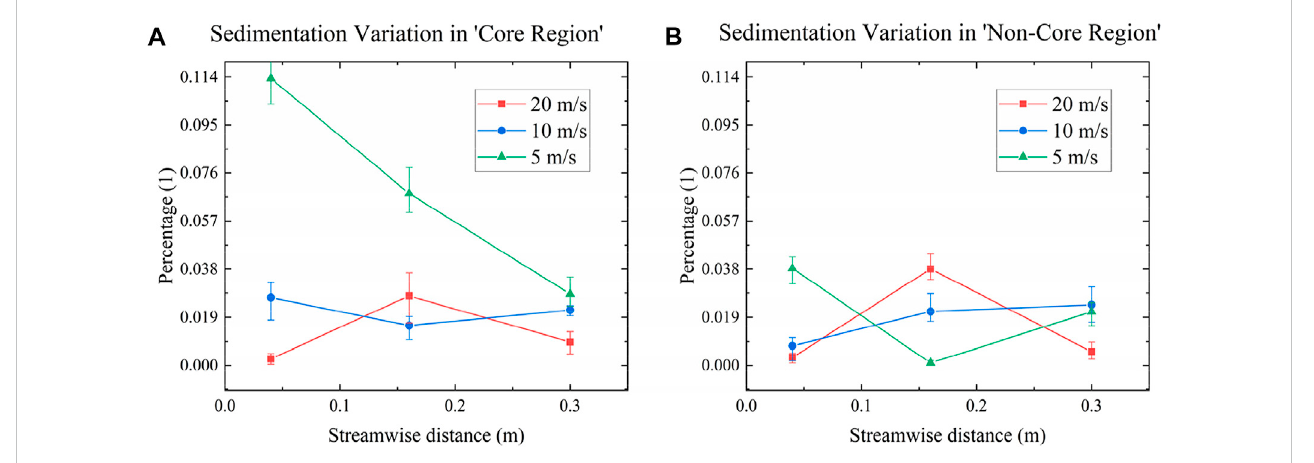
FIGURE 4 Sedimentation percentage from the upstream invasion in the core region (A) , and non-core region (B)